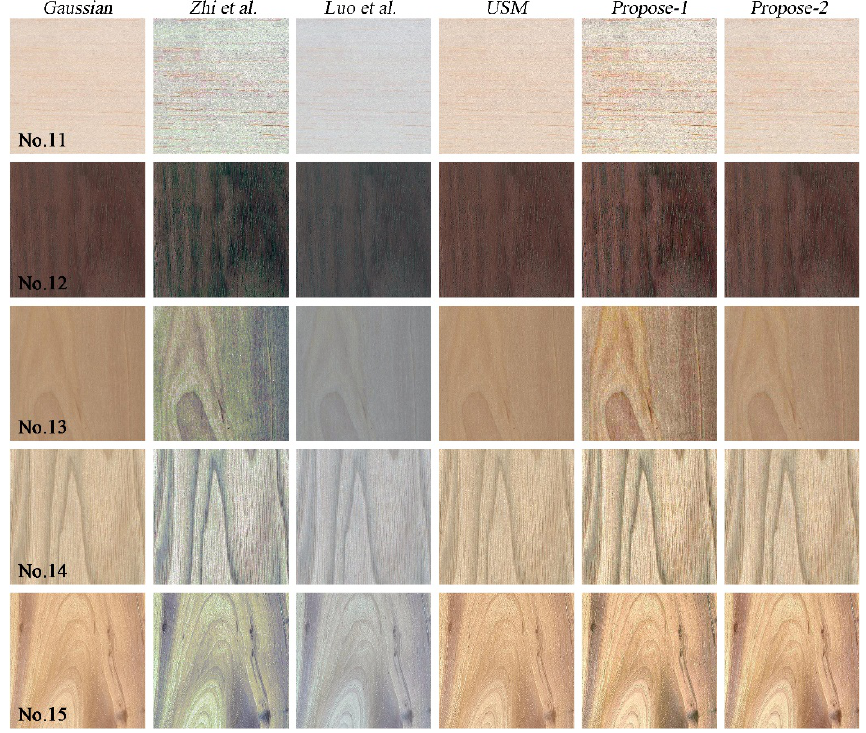
Figure 10. Subjective comparisons on the five wood grain images. From left to right: Gaussian images, the results of Zhi et al. [27], Luo et al. [5], USM [24], the proposed algorithm before modification, and the proposed algorithm at the unified 1.5